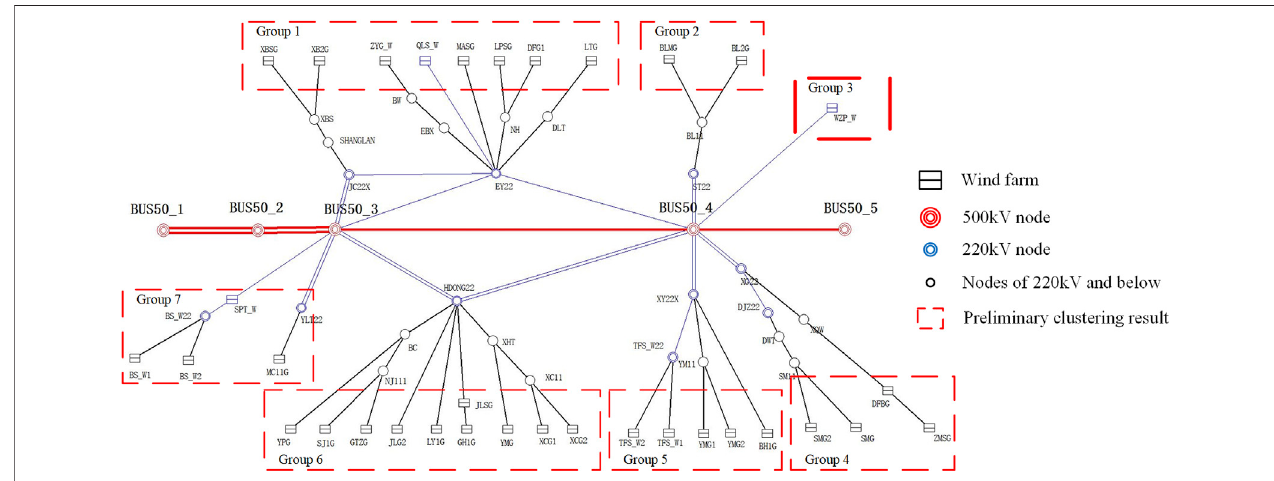
FIGURE 11 | Geographical wiring diagram of